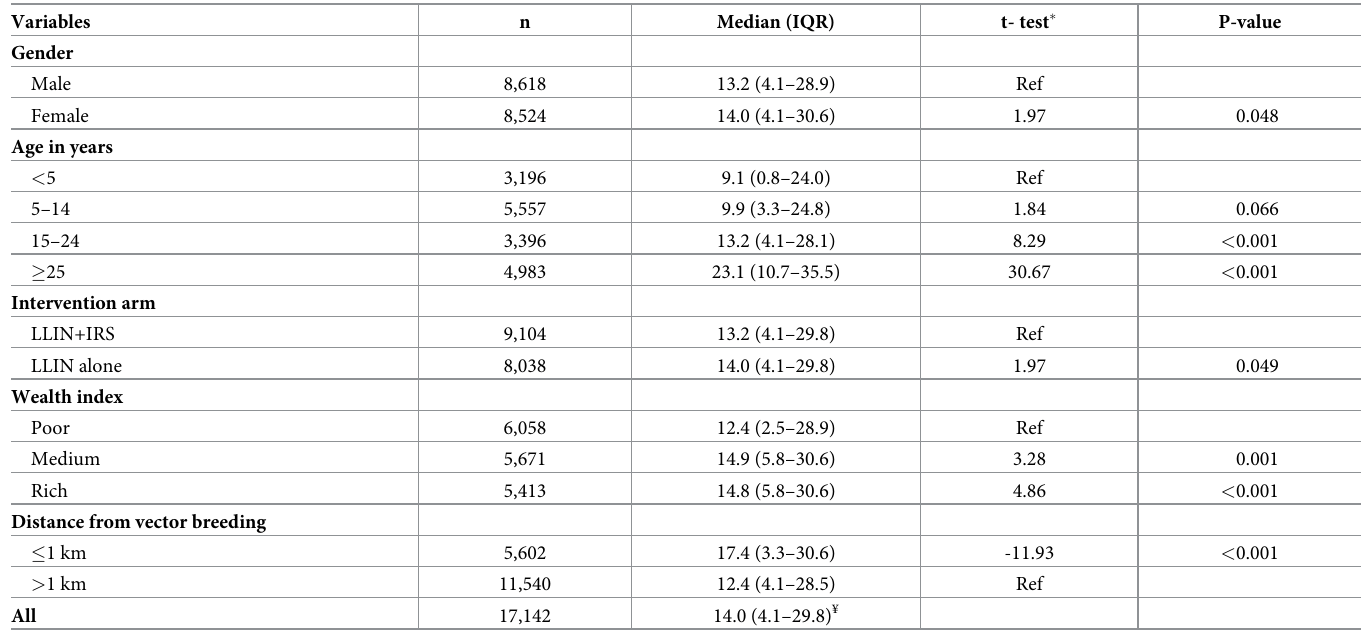
Table 4. The median (IQR) proportion of weeks individuals used an LLIN during 121 weeks from October 2014 to January